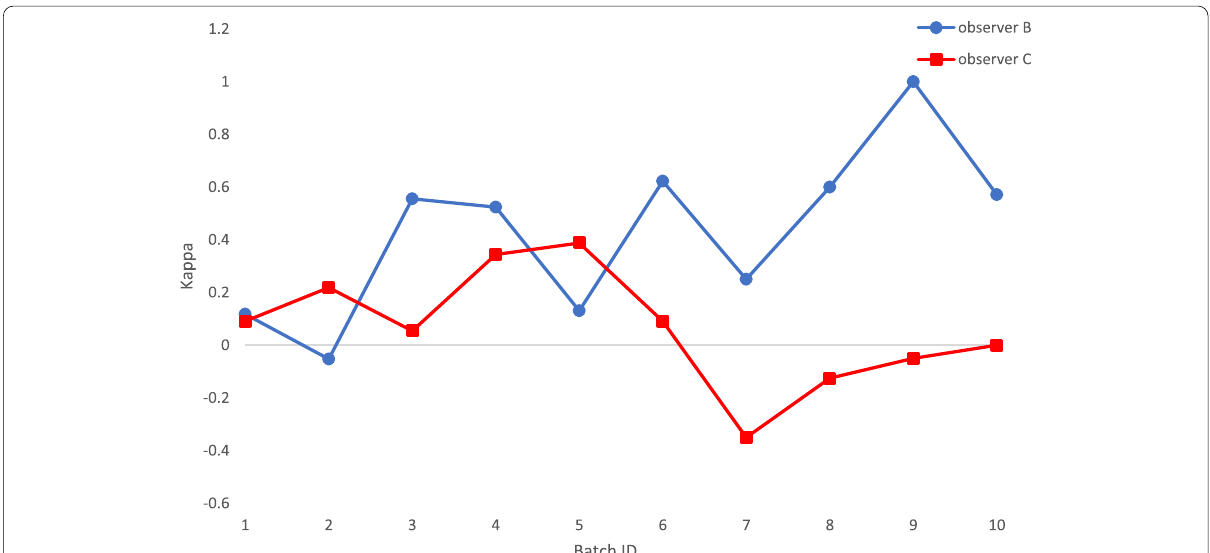
Fig. 1 Kappa values for the variation between the novice observers and the experienced observer on the velum level after each cluster of 10